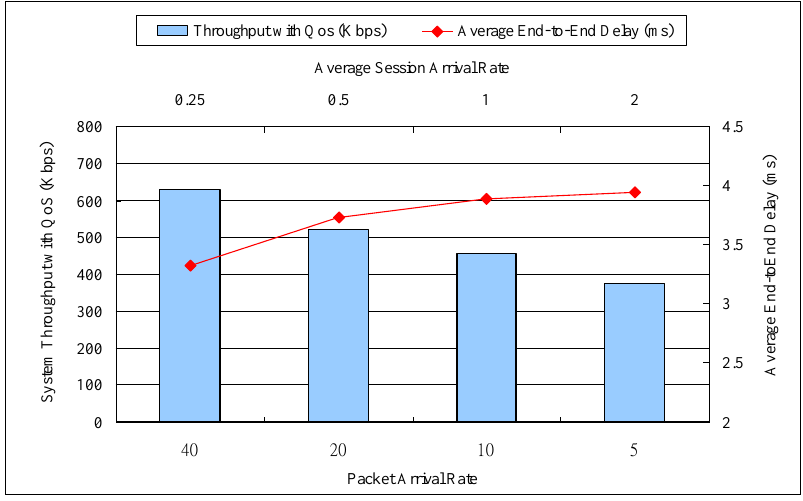
Figure 5. Evaluation with different session arrival